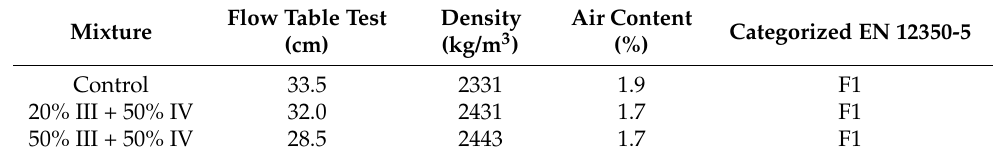
Table 6. Results of tests on fresh concrete mixtures.